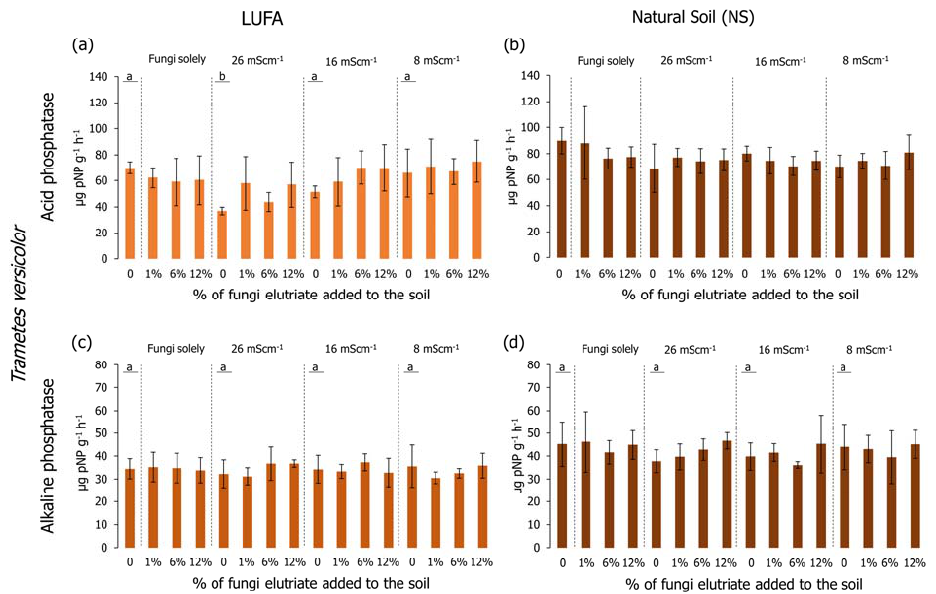
Figure 6. Acid (graphics a , b ) and alkaline (graphics c , d ) phosphatase activity (pNP/g soil/h) at the end of the 96-h germination and seedling growth assay with Lens culinaris in which two different soils at three salinity levels (mS · cm − 1 ) were supplemented with Trametes versicolor rot fungus exudates. Vertical bars represent the standard deviation. Letters indicate homogenous groups between salinity levels solely (Holm-Sidak, p < 0.05).